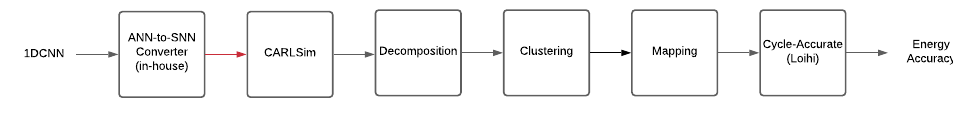
Figure 10. The NeuroXplorer framework [41].